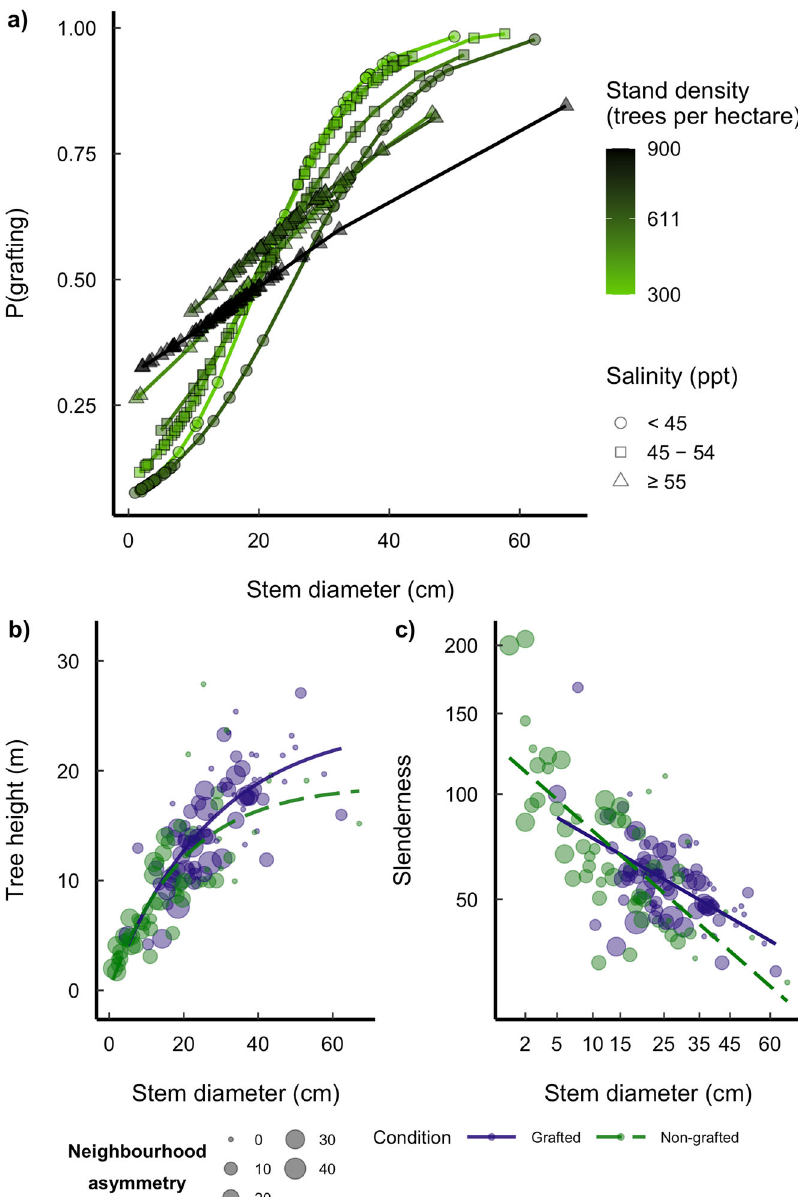
Fig. 2 Probability of rafting and allometric differences between grafted and non-grafted trees. a Logistic regression testing the main drivers of root grafting. Although, for all cases, the probability of grafting increases with increasing stem diameter, at higher salt stress (symbols) and total density values (colour scale), trees graft at smaller stem diameters, and the probability curve rises earlier and is steeper ( N = 324); b , c Allometric patterns in relation to neighbourhood asymmetry (circle size) and grafting ( N = 141); b Non-linear relationship between stem diameter and tree height showcasing stem diameter – height allometric curves that are steeper for grafted (purple) trees compared with non-grafted (green) trees. There is a predominance of grafted trees with stem diameters >20 cm, whereas the tallest trees are either grafted or have smaller values of neighbourhood asymmetry; c Sharp decrease in slenderness coef fi cient with increasing stem diameter for non-grafted trees, at higher stem diameters grafted trees are more